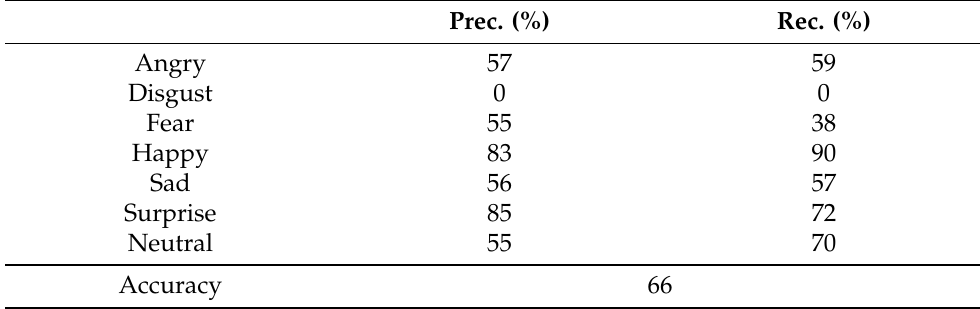
Table 7. Precision, recall and accuracy in the balanced FER2013 validation set. Prec. (%) Rec.